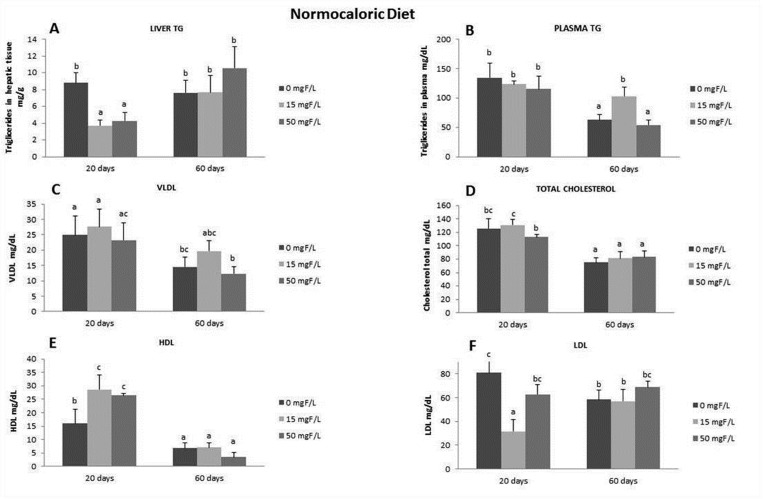
Lipid profile in animals fed normocaloric diet: Means of the lipid profiles in plasma and liver of rats treated with normocaloric diet receiving different fluoride concentrations in the drinking water for 20 or 60 days. A) TG plasma; B) TG liver, C) VLDL, D) Cholesterol, E) HDL, F) LDL. For each variable, distinct upper case superscripts indicate significant differences among the groups (2-way ANOVA and Tukey’s test, p<0.05).